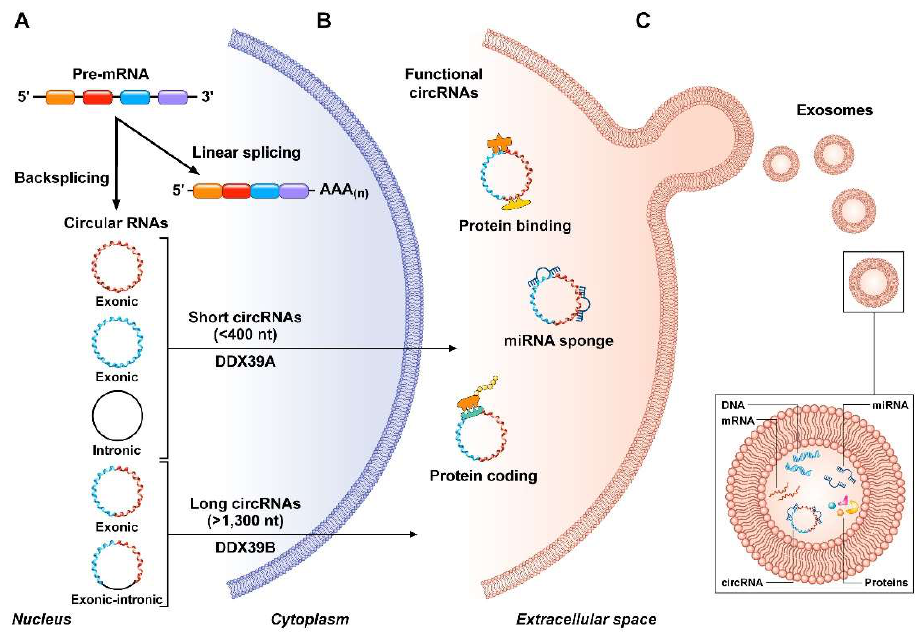
Figure 1. CircRNA biogenesis and functions. ( A ) Circularization of circRNAs, including exonic, intronic, and exonic-intronic circRNAs, arises from pre-mRNA transcripts through different mecha- nisms of back-splicing. After formation, circRNAs are transported from the nucleus to the cytoplasm by RNA helicases (DDX39A, or DDX39B) in a size-dependent manner. ( B ) CircRNAs have different mechanisms of action. Indeed, they can interact with proteins, encode for proteins, and function as microRNA sponge (mainly). ( C ) CircRNAs can be further released into body fluids as cell-free circR- NAs or enriched in extracellular vesicles (e.g., exosomes).